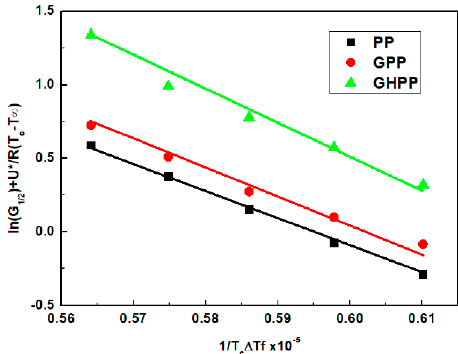
Table 3. The kinetic parameter for crystal growth ( K g ) and interfacial free energies of crystal growth ( σ e ) under self-nucleation isothermal crystallization process. Figure 9. Lauritzen–Hoffman kinetic theory plot for PP, GPP, and GHPP. Figure 9. Lauritzen–Hoffman kinetic theory plot for PP, GPP, and GHPP.